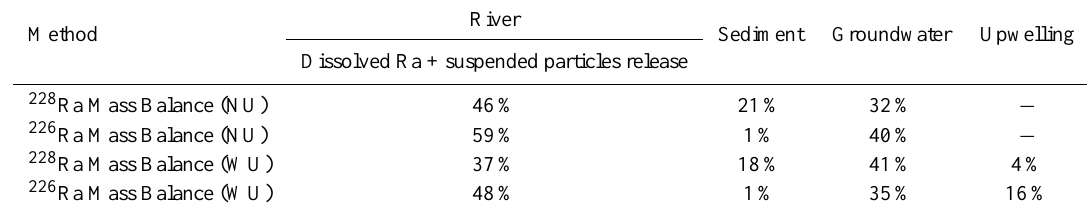
Table 5. Fractional contributions of various sources to the total 226 Ra and 228 Ra flux into the northern South China Sea shelf.